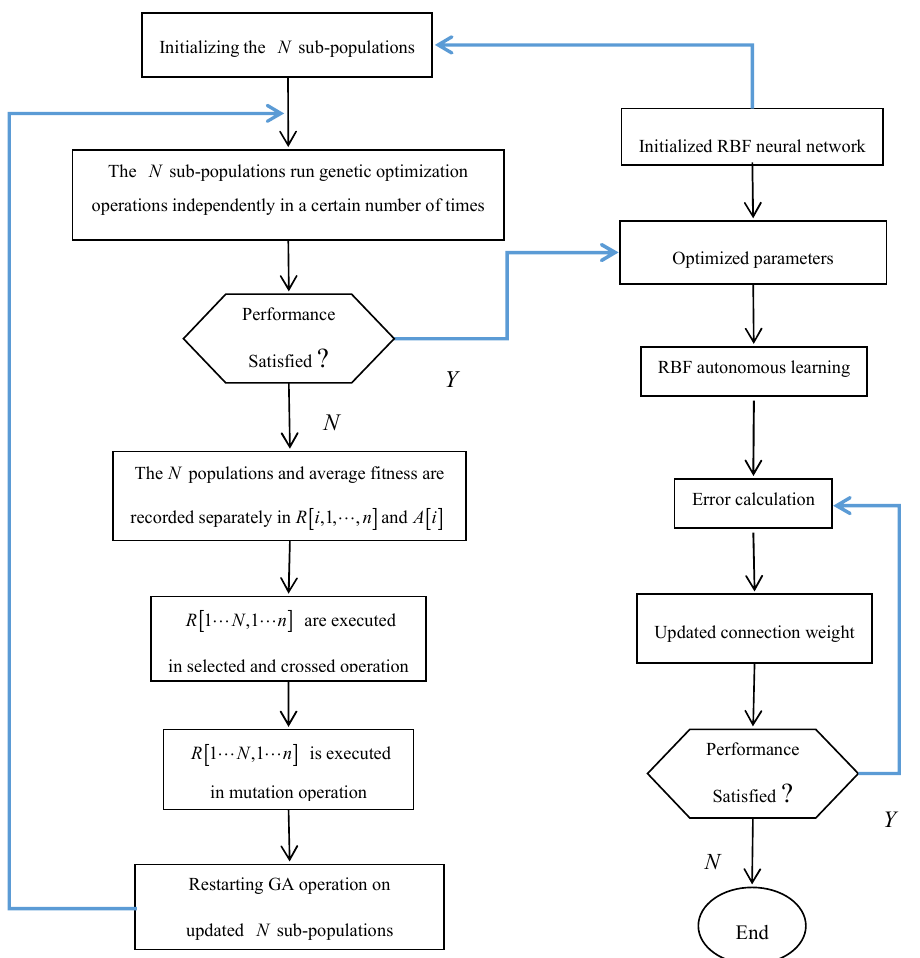
Figure 2. The process of the neural network optimization with the improved genetic algorithm .